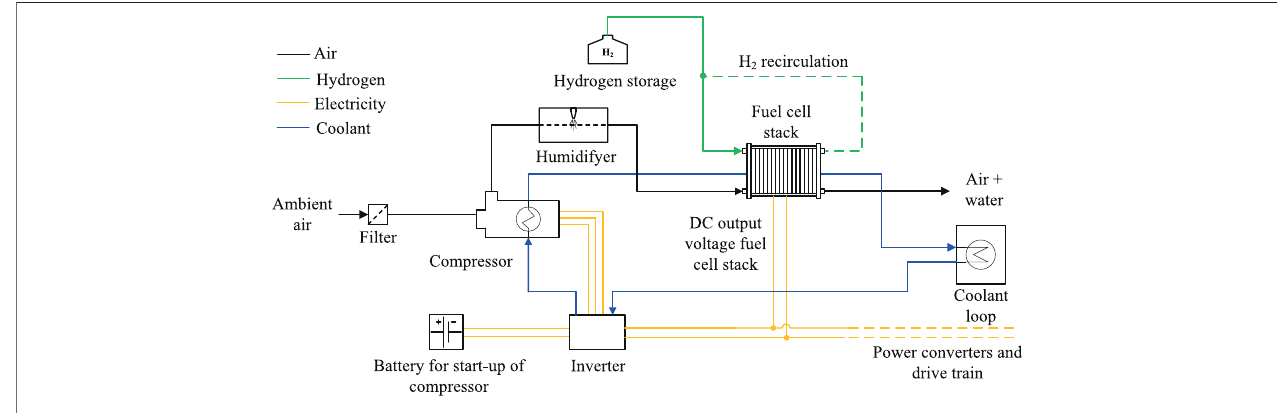
FIGURE 2 | Overview of the Balance of Plant (BoP) for an exemplary fuel cell system.